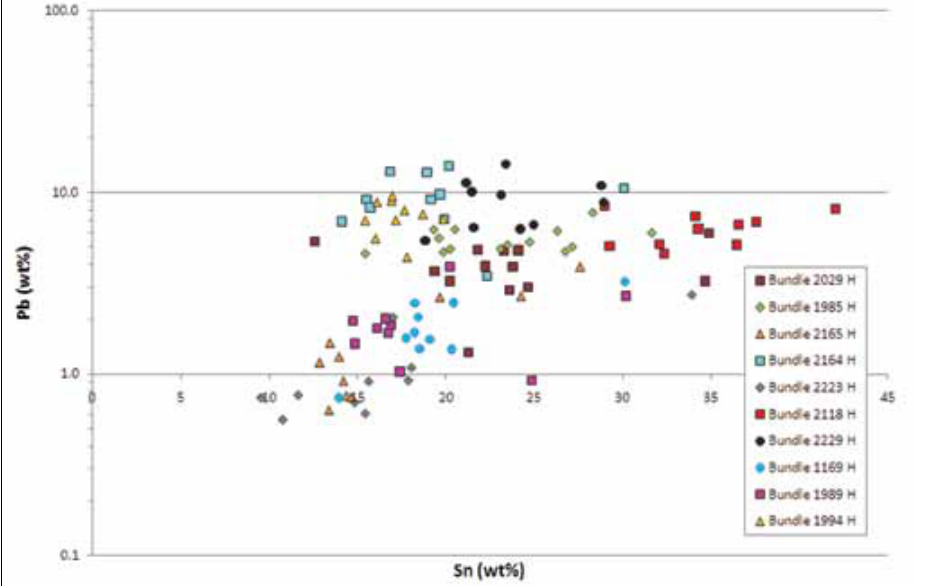
Fig. 10: Scatterplot of the composition of some arrowheads discriminated by bundle; note the clustering of each bundle denoting an individual metal